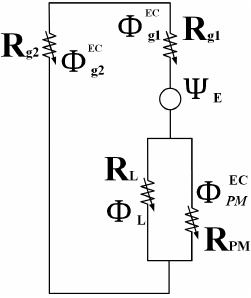
Figure 6. Equivalent magnetic circuit of power-on